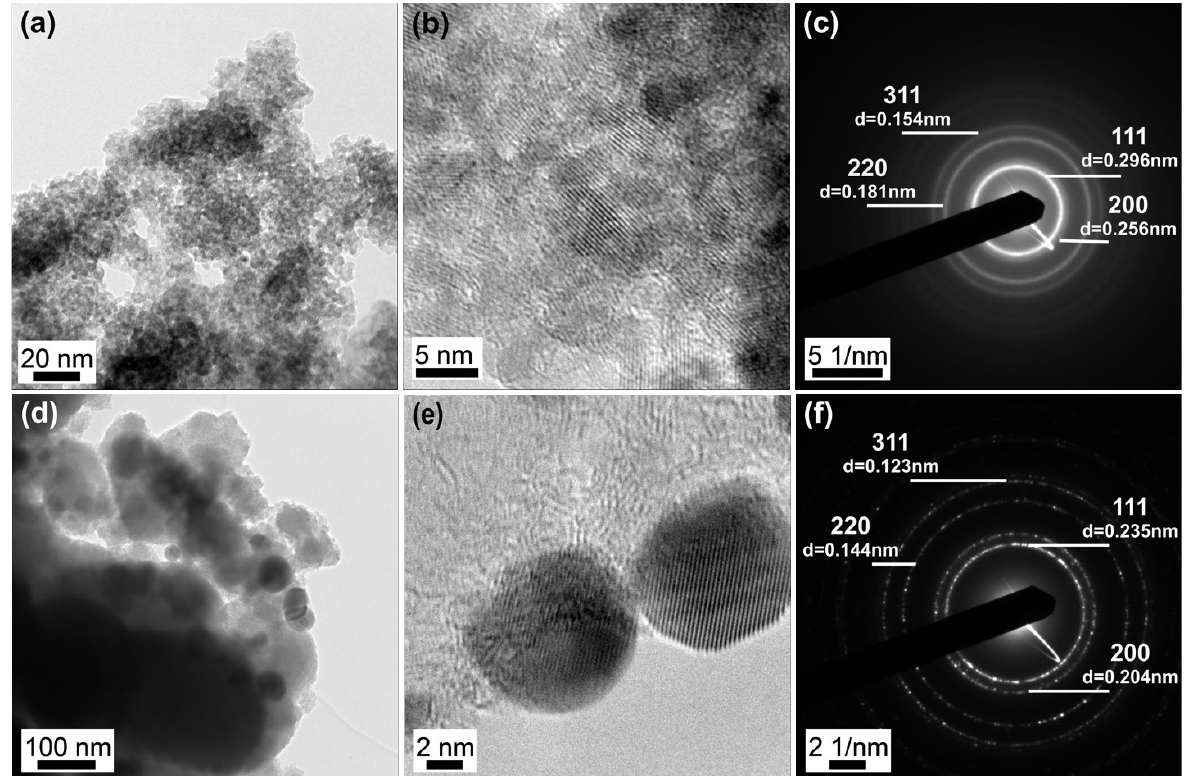
Figure 2. TEM images at different magnifications of unmodified ZrO 2 ( a , b ) and ZrO 2 /DHQ/Ag powders ( d , e ) and corresponding SEAD patterns ( c , f , respectively).